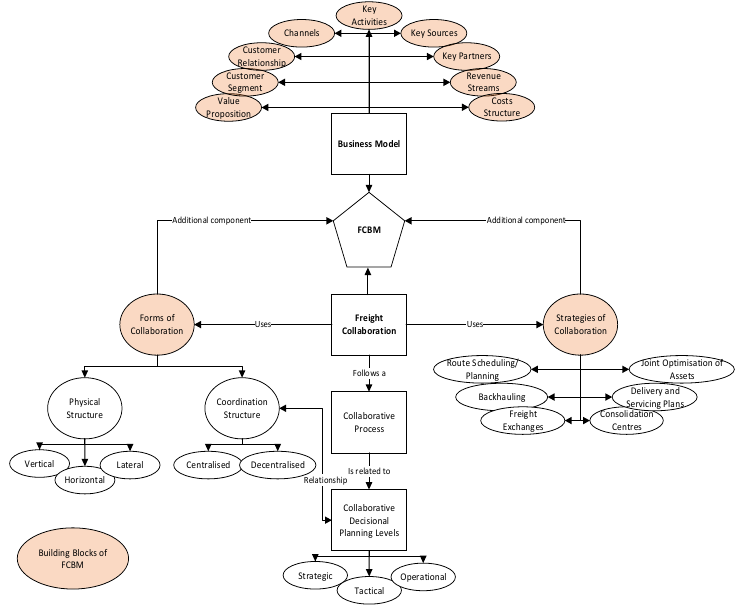
Figure 4. Conceptual framework for freight collaborative business model (FCBM).